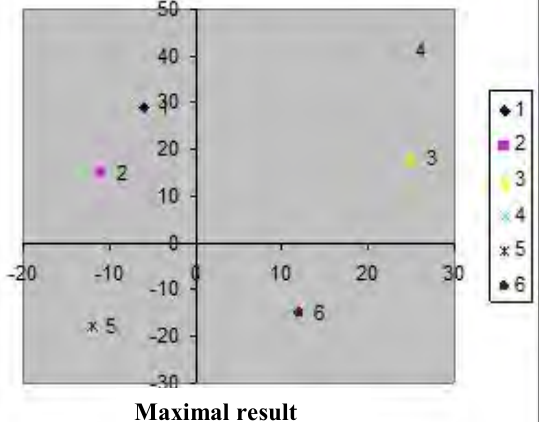
Fig.1. Location of constructs 1-b in the space of two main axes in compliance with the points of interconnections